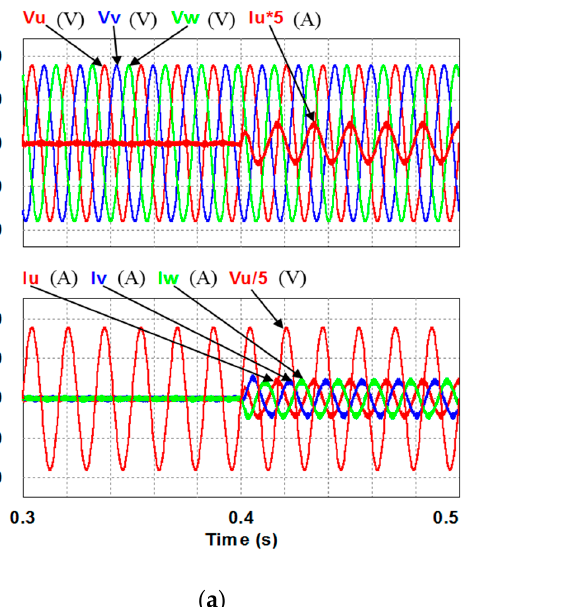
Figure 14. ( a ) Simulation scenario: sequence diagram of reactive power command; ( b) case 1 simulation result: three-phase voltages and currents.